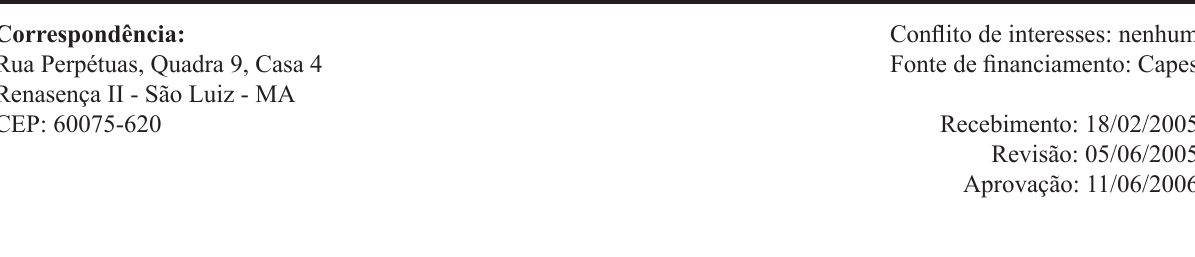
*Figuras coloridas disponíveis em